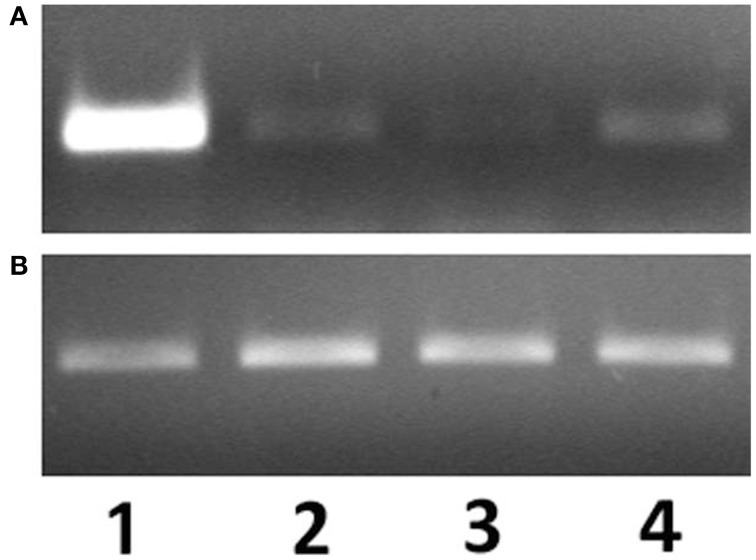
mRNA expression levels of arenicin-1 (A) relatively to actin (B) measured by PCR. Expression levels in coelomocytes (1), body wall (2), pharynx (3), intestine (4).